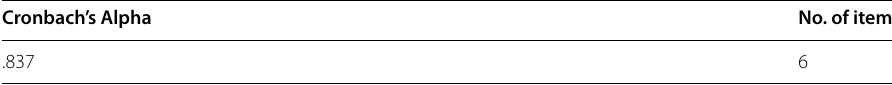
Table 2 Self‑evaluation questionnaire’s